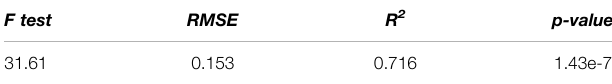
TABLE 3 | Regression results for the proposed empirical model.